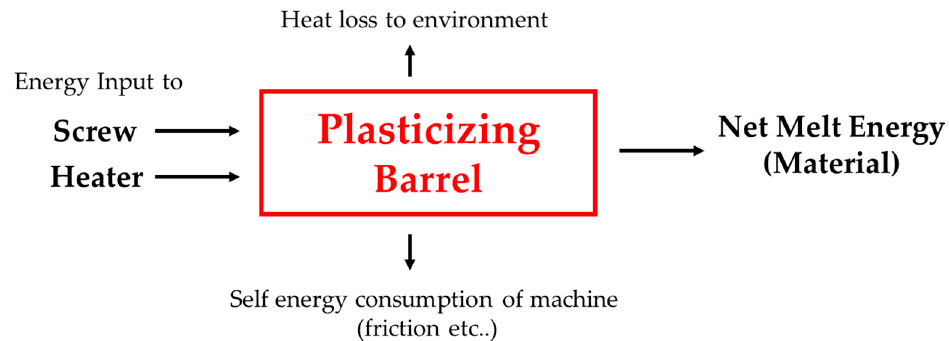
Figure 1. Energy input and loss in the injection molding machine.